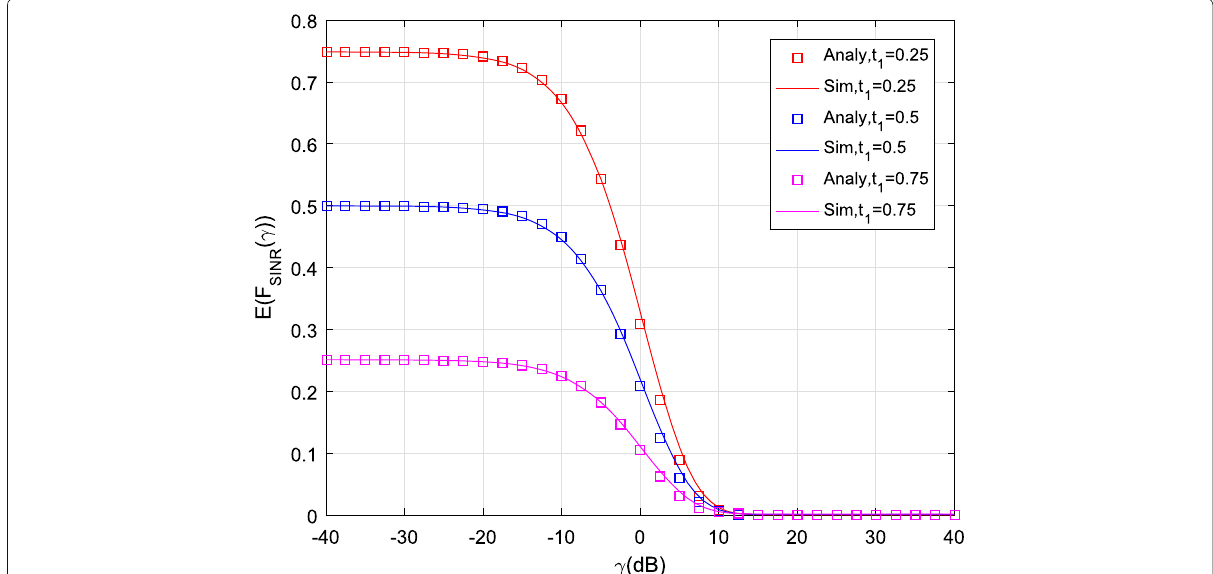
Fig. 14 CCDF of the SINR of the hybrid scheme for the typical MTM with (cid:5) = 1, t ( 1 ) / t ( 2 ) = 9 dB, p max → ∞ , and i 0 = − 90